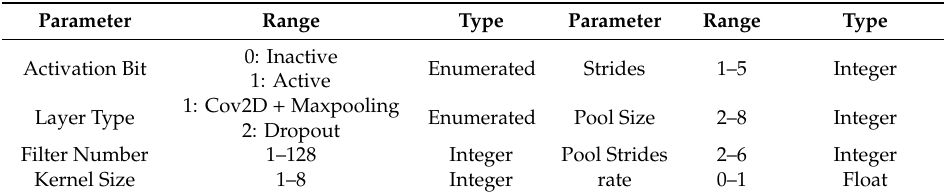
Table 1. Parameters of code blocks for a neural network layer.